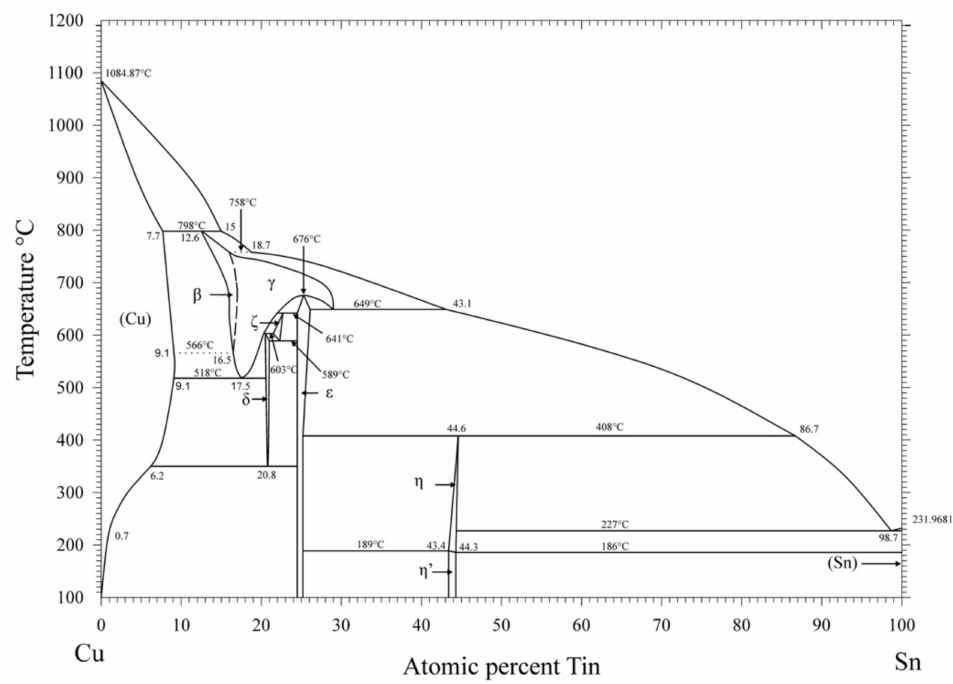
Figure 12. New Cu-Sn phase diagram, as suggested by Furtauer et al.